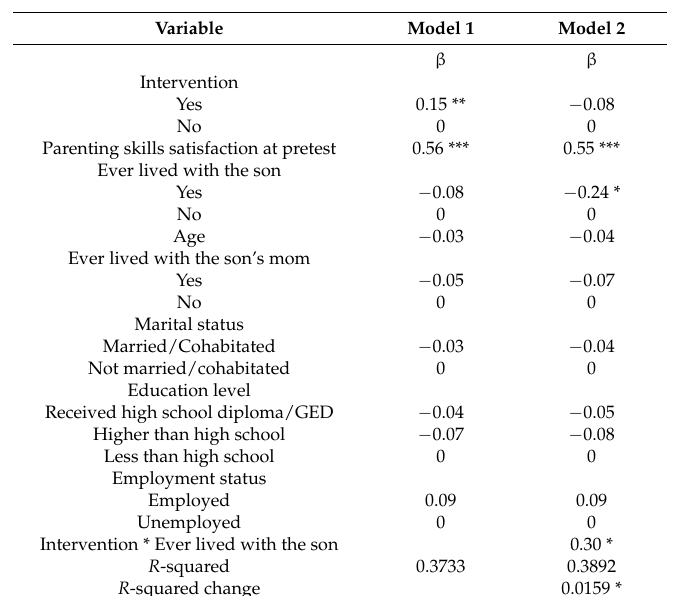
Table 2. Multivariate regression analyses on parenting skills satisfaction at posttest.